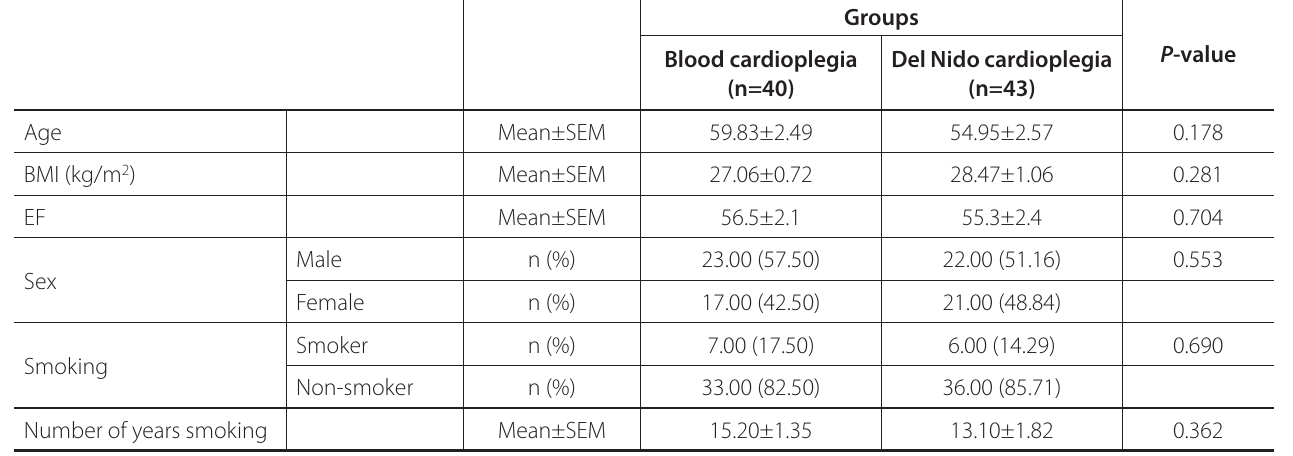
Table 2 . Sociodemographic